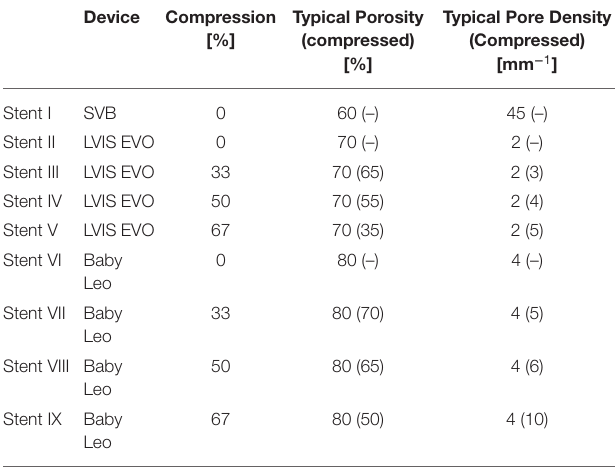
TABLE 1 | Stent porosity and construction.